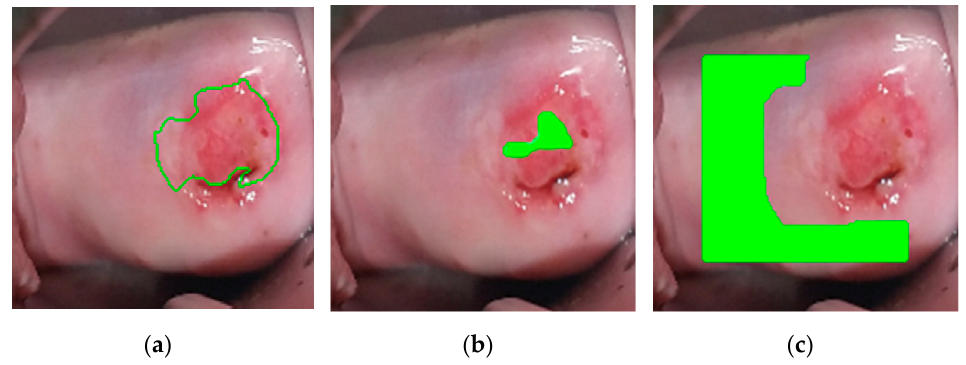
Figure 1. For the supervised learning, positive and negative pixels are chosen from area far from ground truth contours, to avoid mislabeled training data due to inaccurate labeling. From left to right: ( a ) Label drawn by the colposcopist, validated by biopsy, ( b ) eroded label, where positive pixels are chosen from (green region), ( c ) dilated and masked label, where negative pixels are chosen from (green region).